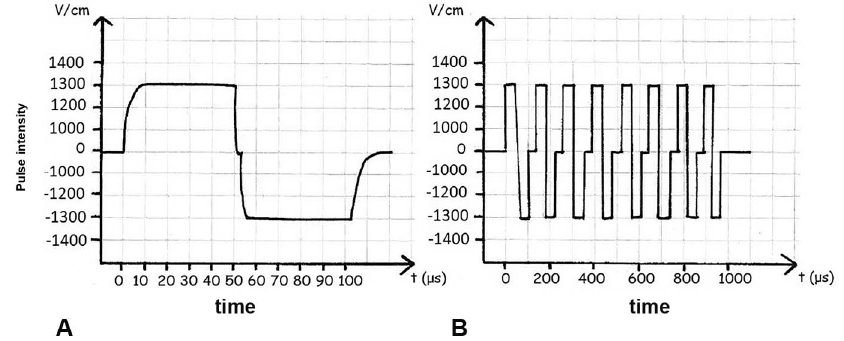
Figure 2. Different electroporation modes: ( A ) square waveforms delivered in a sequence of single pulses; ( B ) application of a series of 8 biphasic pulses, with voltage of 1300 V/cm and duration of 50 + 50 µs (time, t) each.